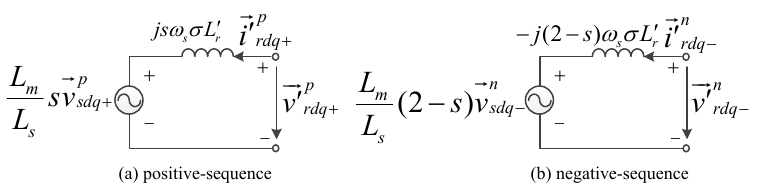
Figure 3. Steady-state equivalent rotor circuit of doubly-fed induction generator